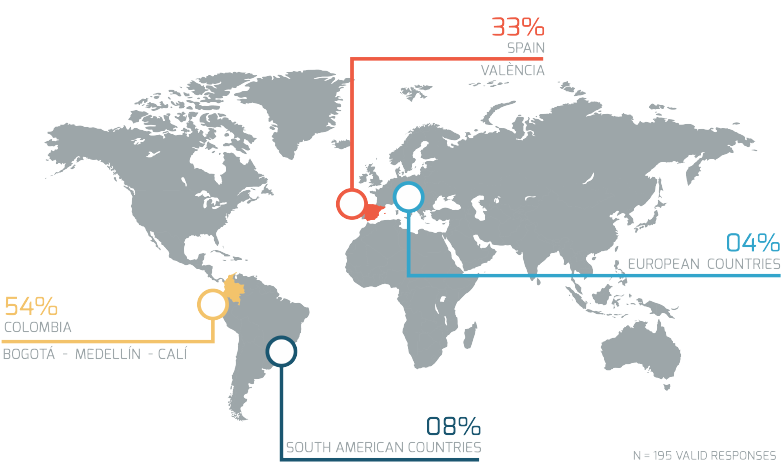
Figure 2. Online survey responses.